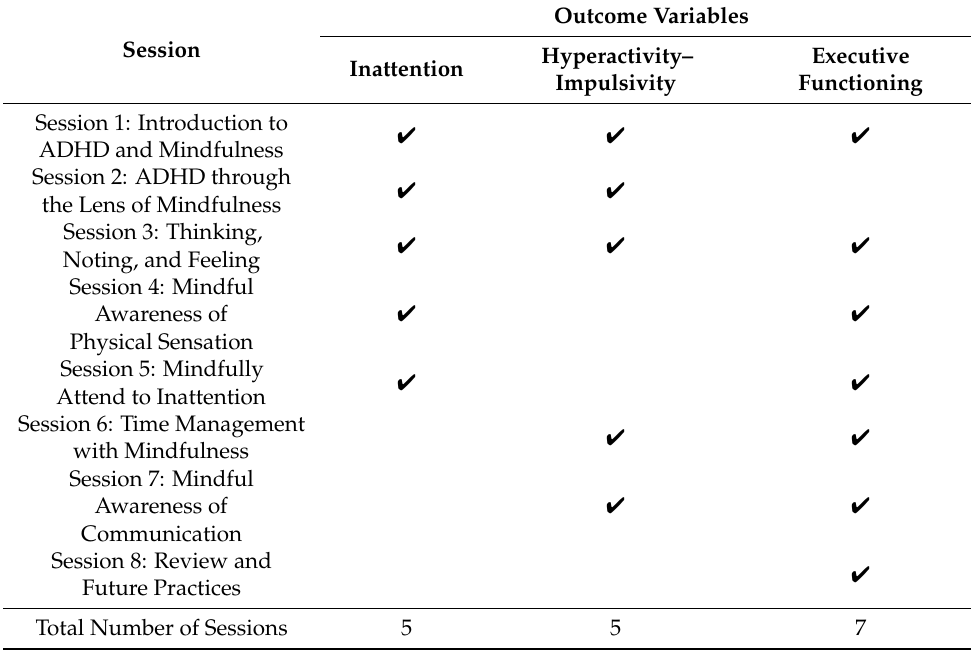
Table 1. Mapping of online mindfulness-based intervention to outcome